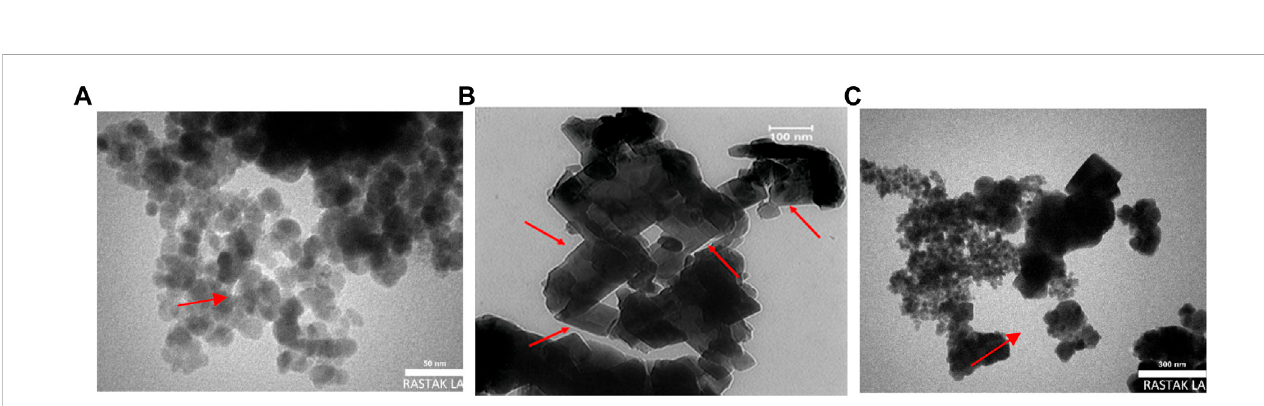
FA-Cisplatin FIT-IR pro fi les are illustrated in Figure 6. FT-IR spectroscopy was used to verify the chemical modi fi cations.